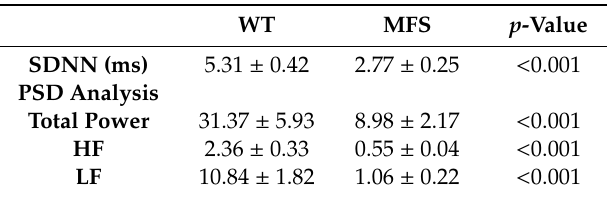
Table 3. Short-term analysis of heart rate variability. n = 27 paired electrocardiogram (ECG) fragments of two minutes obtained in 4 WT and 4 MFS